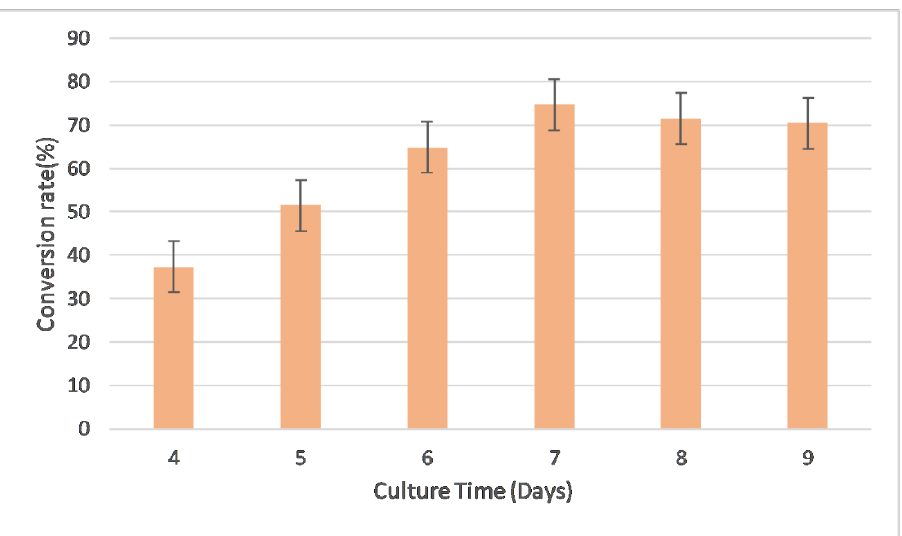
Figure 4. Effects of culture time on metabolite conversion rate (initial pH = 6.5, media volume 50 mL, inoculation volume 10%, substrate concentration 1 mg/mL).